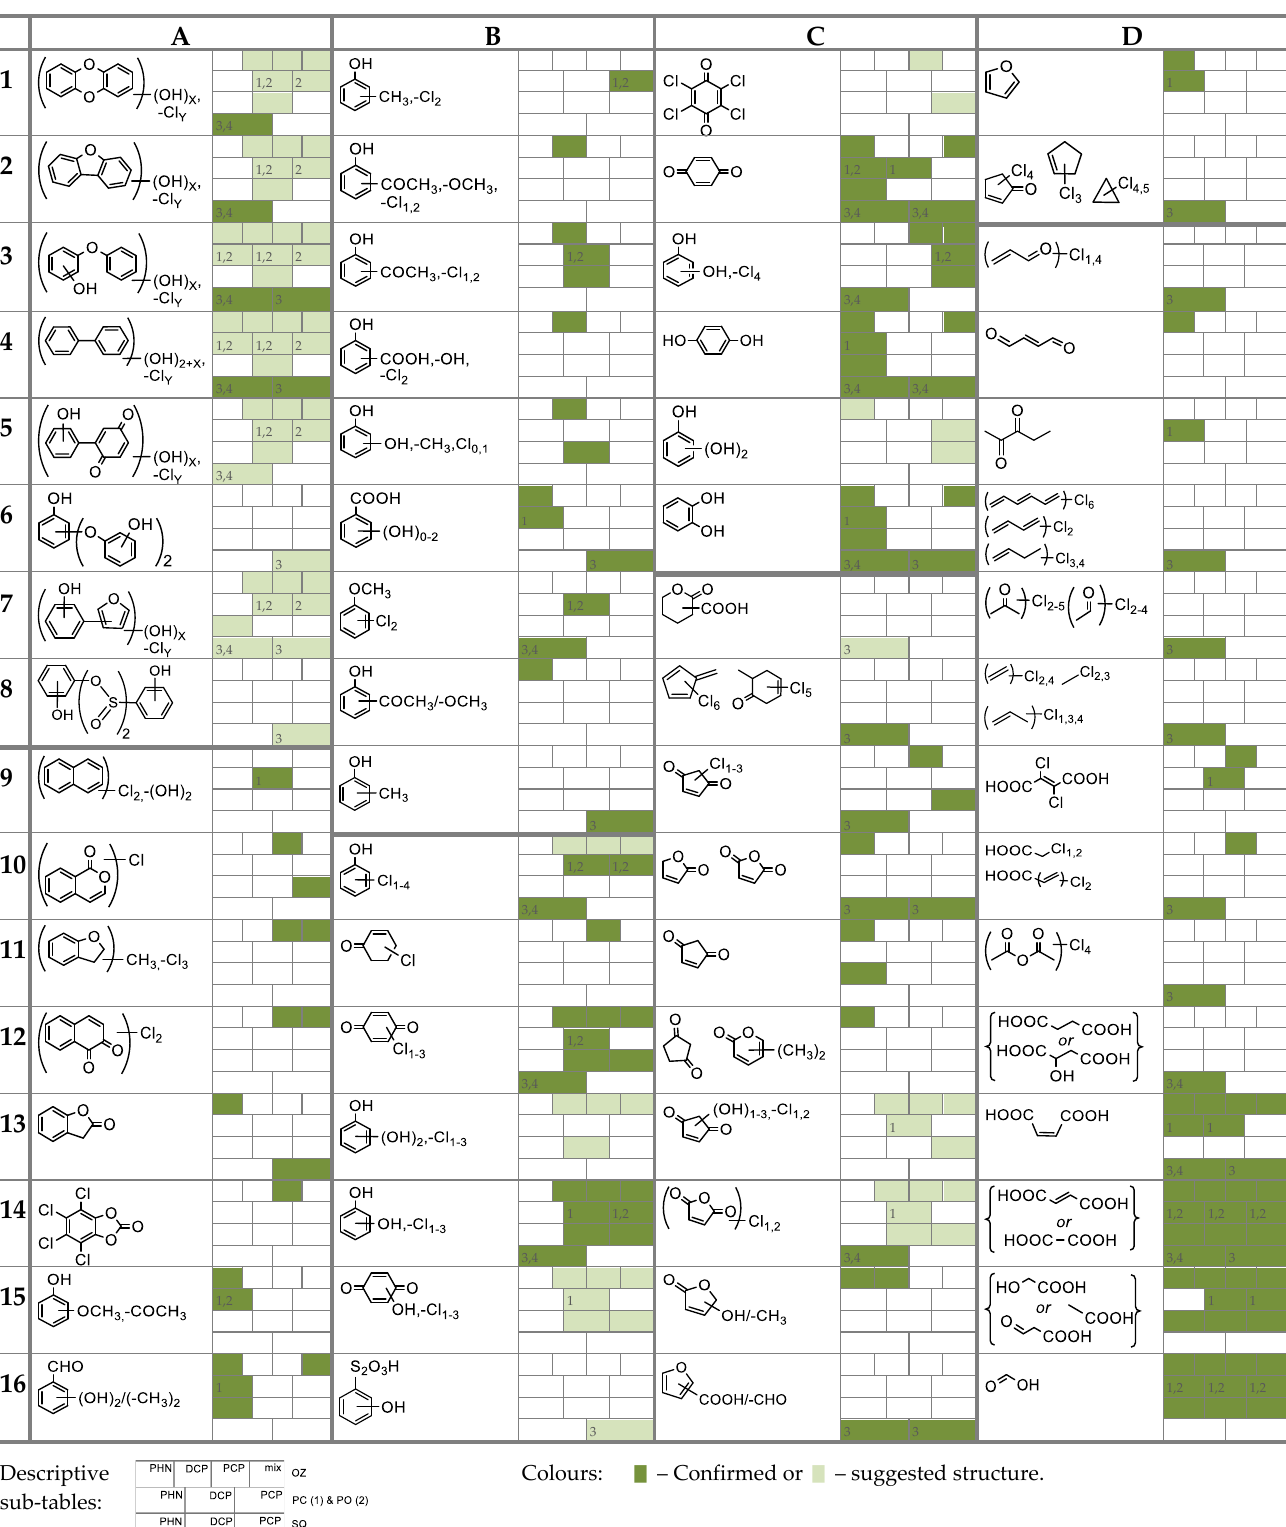
Molecules 2022 , 27 , x FOR PEER REVIEW 12 of 21 Table 2. Transformation by-products (TPs) of phenol (PHN), 2,4-dichlorophenol (DCP), pen- tachlorophenol (PCP) and their mixture during ozonation (OZ), photocatalysis (PC; #1), photooxida- tion (PO; #2), sequential method (SQ), and electrooxidation (EO) with BDD (#3) and MMO (#4) anode in NaCl and Na 2 SO 4 (for decription of table’s structure and colours, see footnotes).